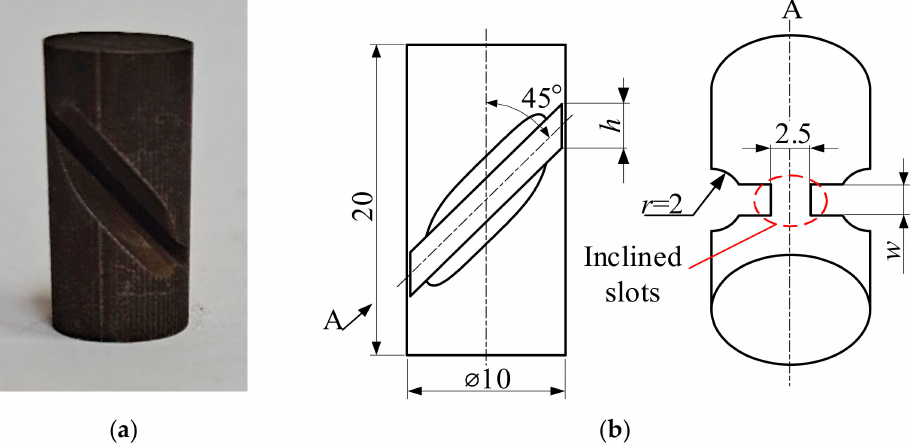
Figure 2. Sample of a shear-compression specimen (SCS). ( a ) Description of physical map; ( b ) de- scription of size map (unit of measurement is